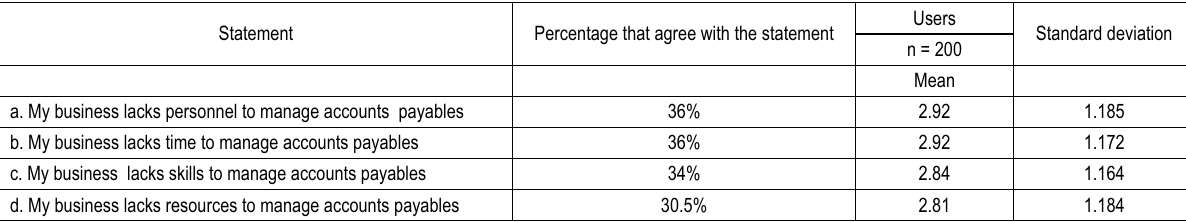
Table 3. Factors that inhibit SMMEs from managing their accounts payable effectively